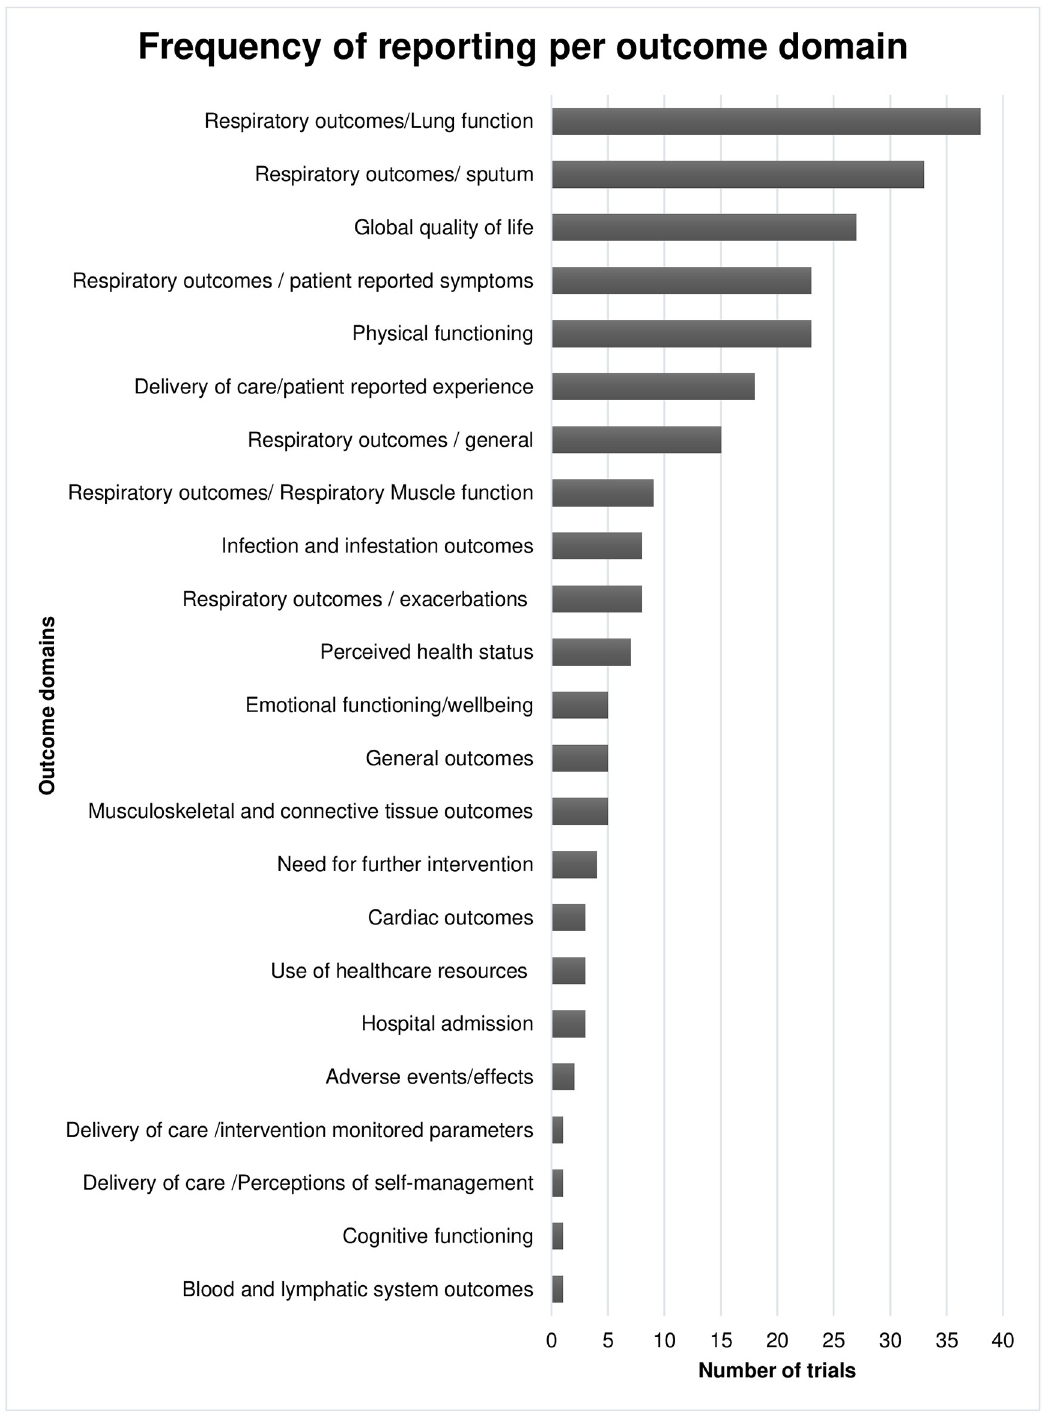
Fig 2. Types of physiotherapy interventions used across included studies.